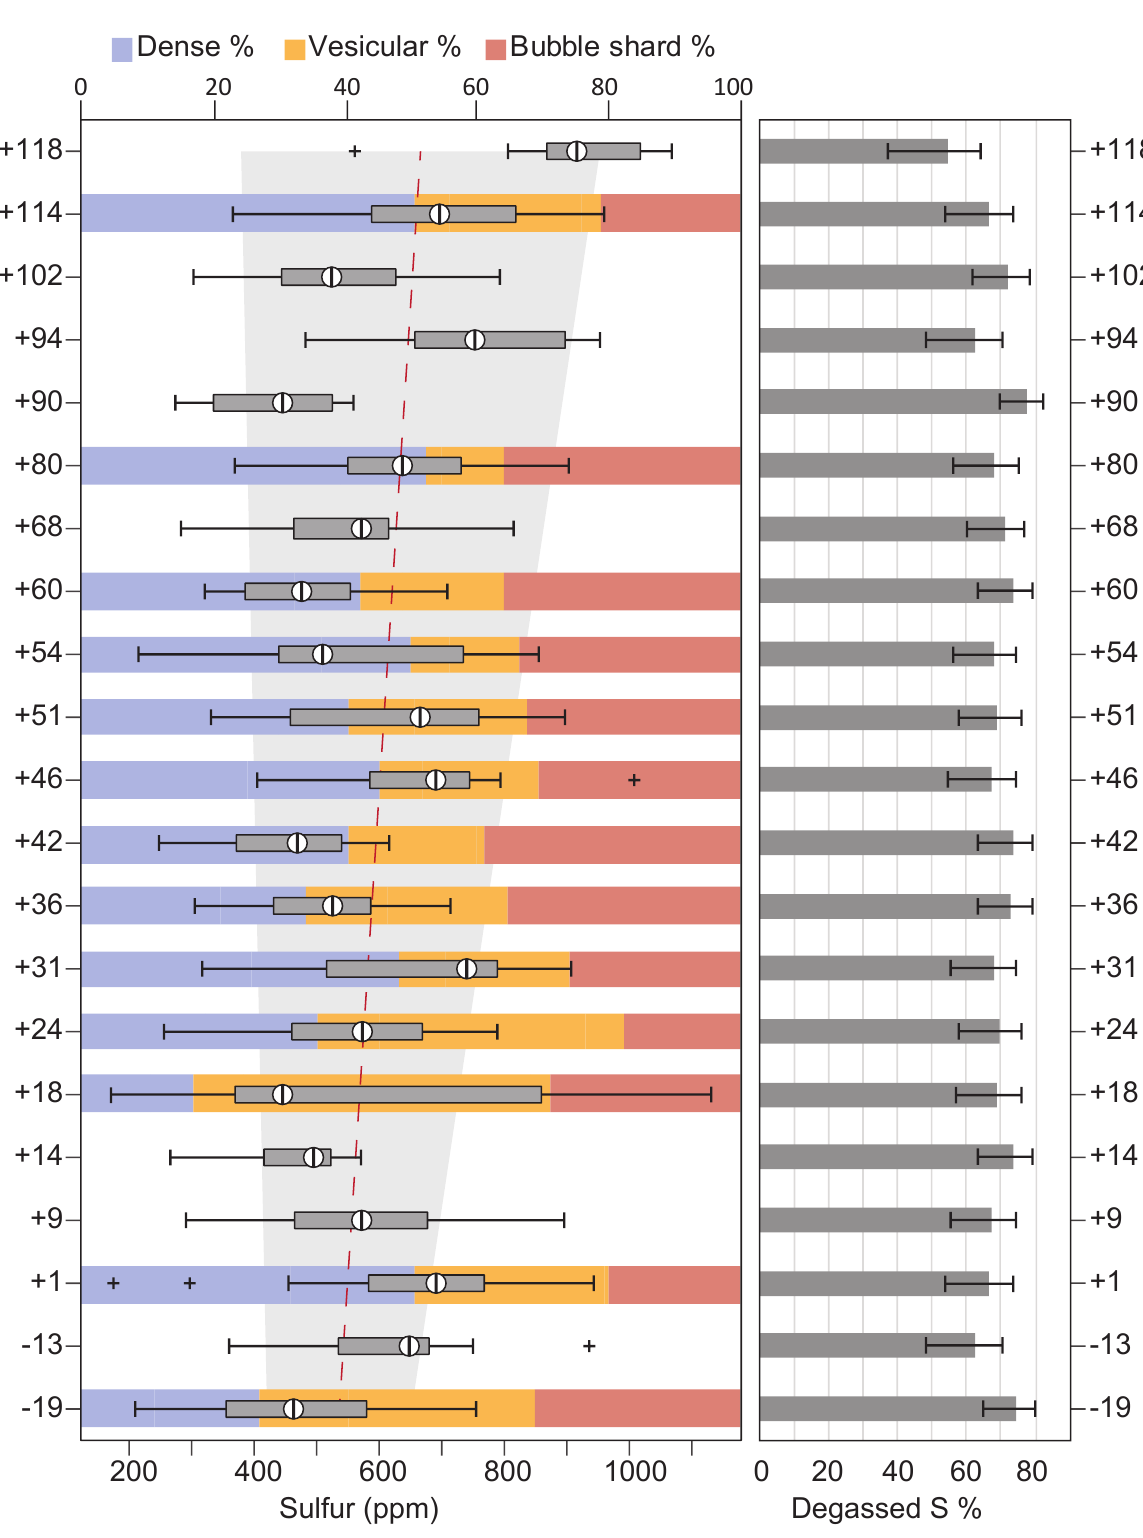
Figure 10: To the left: Bar chart of the morphological distribution and boxplots of sulfur concentrations, both stratigraphically sorted. In the boxplot, each box indicates the 25 th and 75 th percentiles of the ash sample, with the circle and line inside indicating the median value. Whiskers indicate 0.05 and 95 percentiles, and black crosses are outliers. The red line shows the linear regression ( r 2 = 0.12) of the median sulfur values, with median grey band indicating 95 % confidence intervals. To the right: Percent degassed S, the calculation is discussed in detail in Section 5.2.1 . Data in Tables S1, S3, and S4, Supplementary